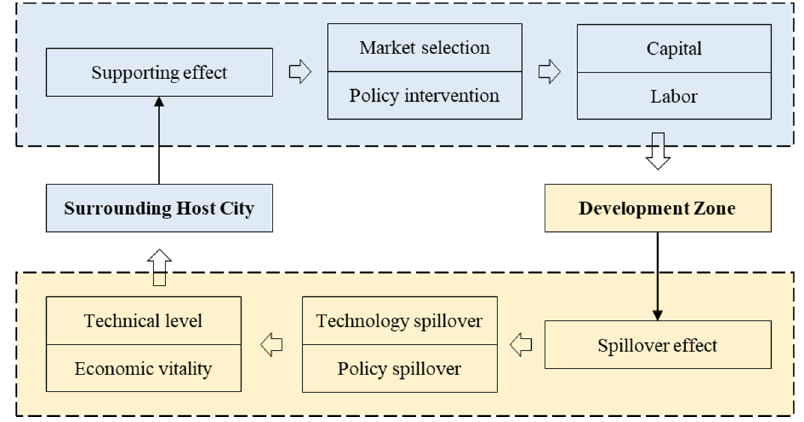
Figure 1. The interaction mechanism between the DZ and the SHC.